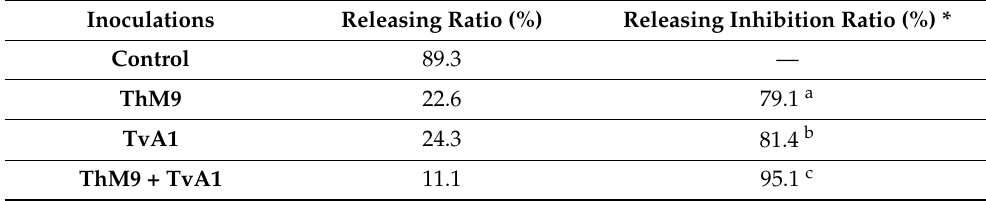
Table 3. Endophytic efficacies against cucumber DM tested by sporangia-releasing inhibition assay. * Different letters represent significant